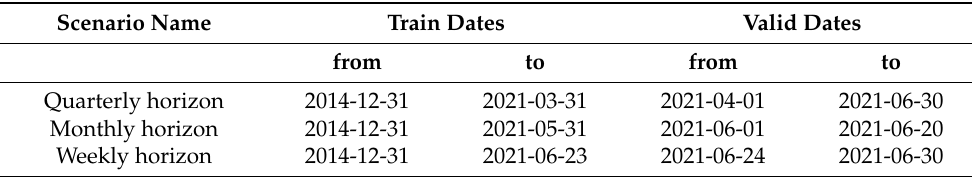
Table 2. Forecasting